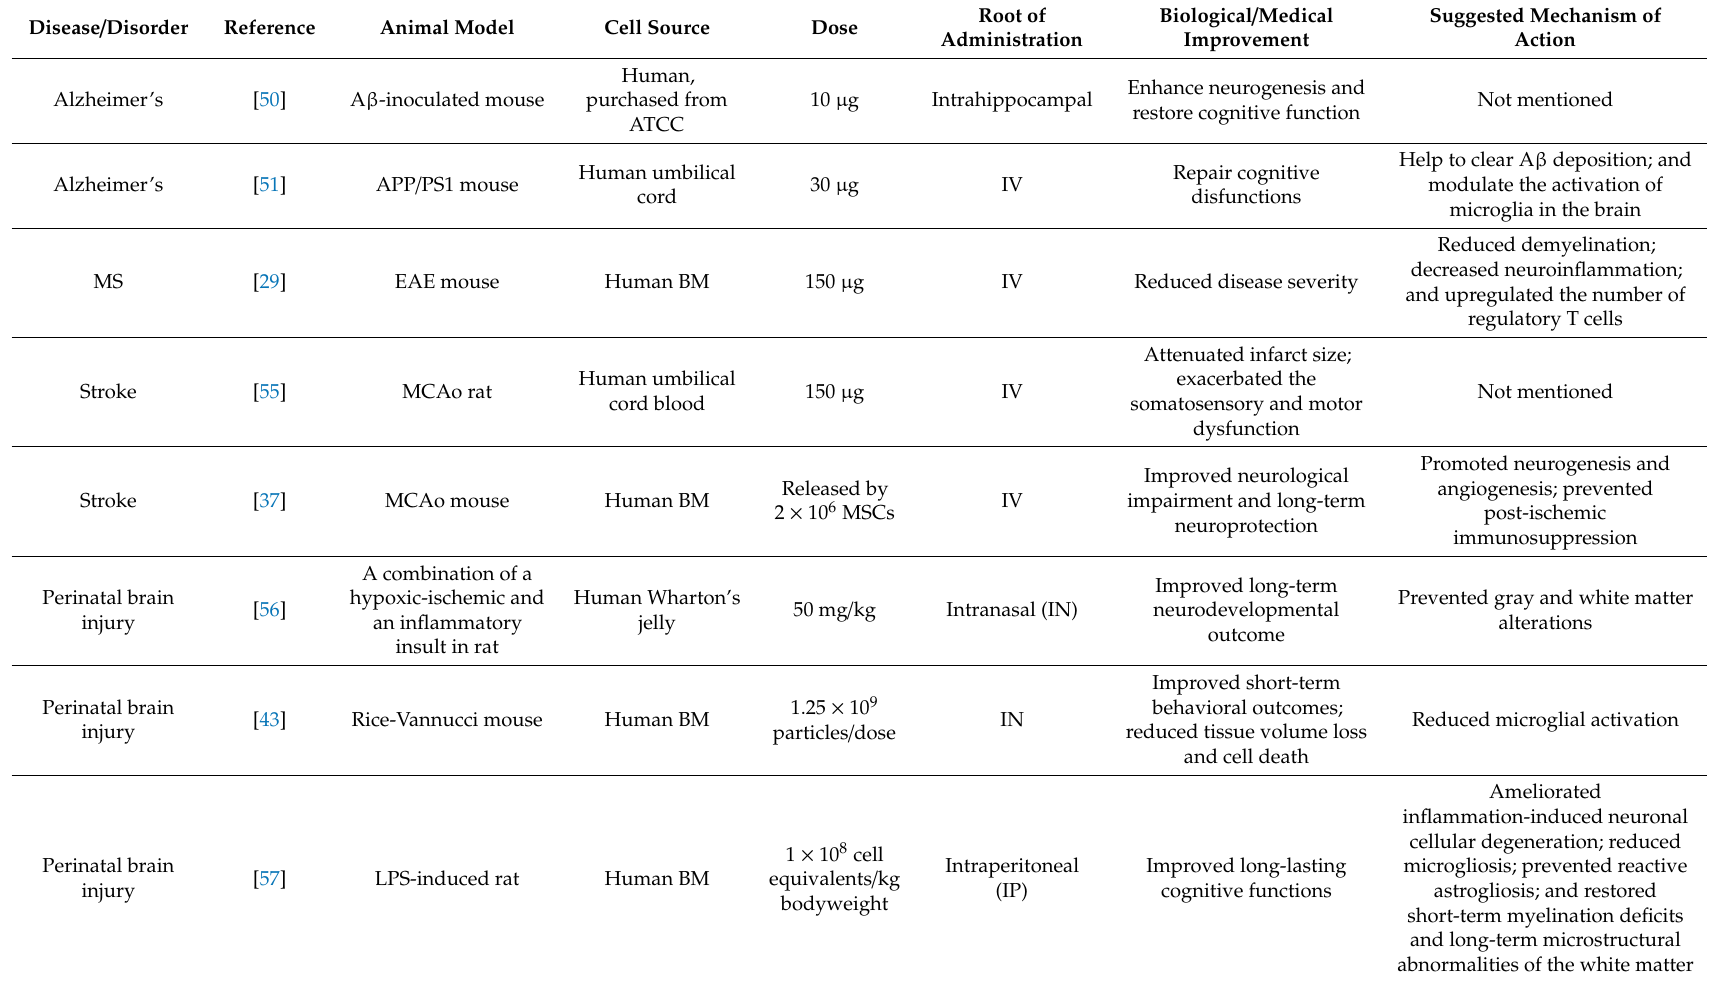
Table 1. Naïve human MSC-derived exosomes in animal models of